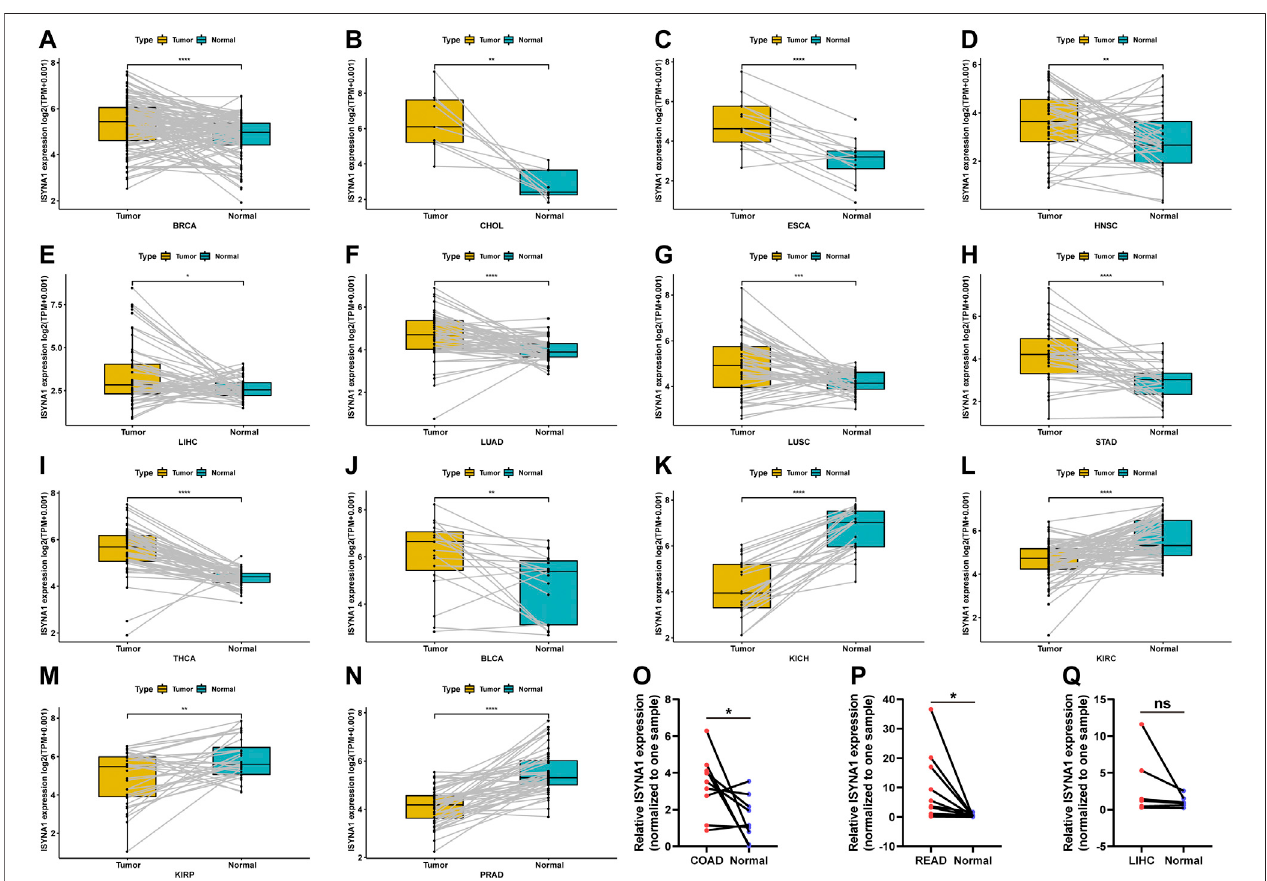
FIGURE 2 | (A – N) ISYNA1 expression in paired tumor and adjacent normal tissues from TCGA in indicated tumor types. (O – Q) ISYNA1 expression in COAD, READ, and LIHC based on the qRT-PCR assay. * p < 0.05, ** p < 0.01, *** p < 0.001, **** p < 0.0001.